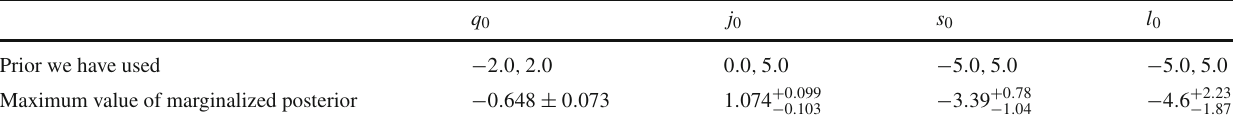
Table 1 The prior and maximum value of marginalized posterior for each of cosmography parameters and their 1 σ uncertainties obtained in the model independent (MI) approach using Pantheon+BAOs+CCH as data combination